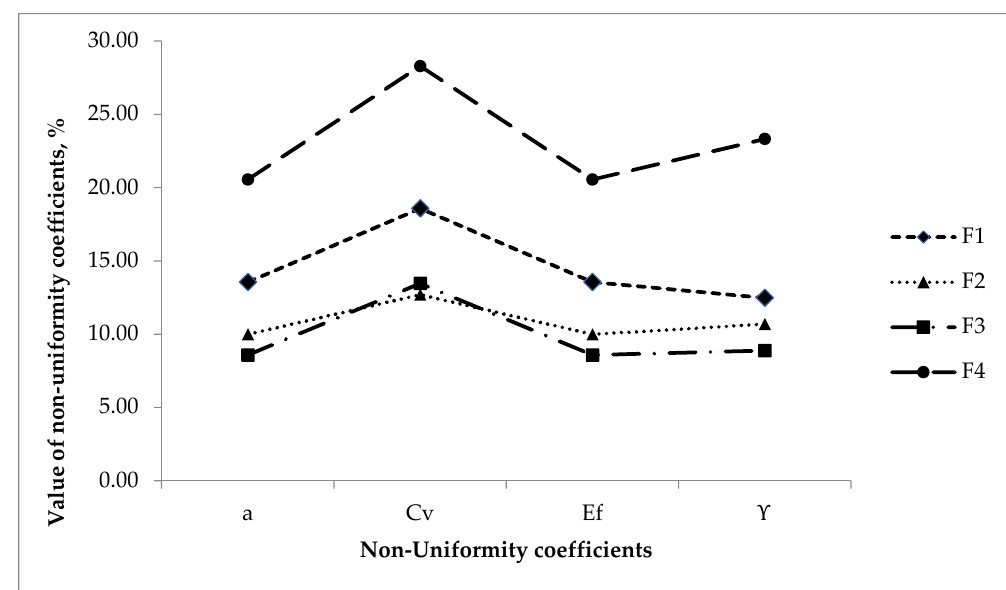
Figure 6. The results of different uniformity coefficients for all experimental fields, for T2 where: ar—coefficient of uniformity according to Oehler, CUH—coefficient of uniformity according to Heerman and Hein, CU—coefficient of uniformity according to Christiansen, Cws—coefficient of uniformity according to Wilcox and Swailes, γ r—coefficient of uniformity according to Voigt, CUhr—coefficient of uniformity according to Hart and Raynolds, CUcr—coefficient of uniformity according to Criddle et al., X—average values in individual samples.